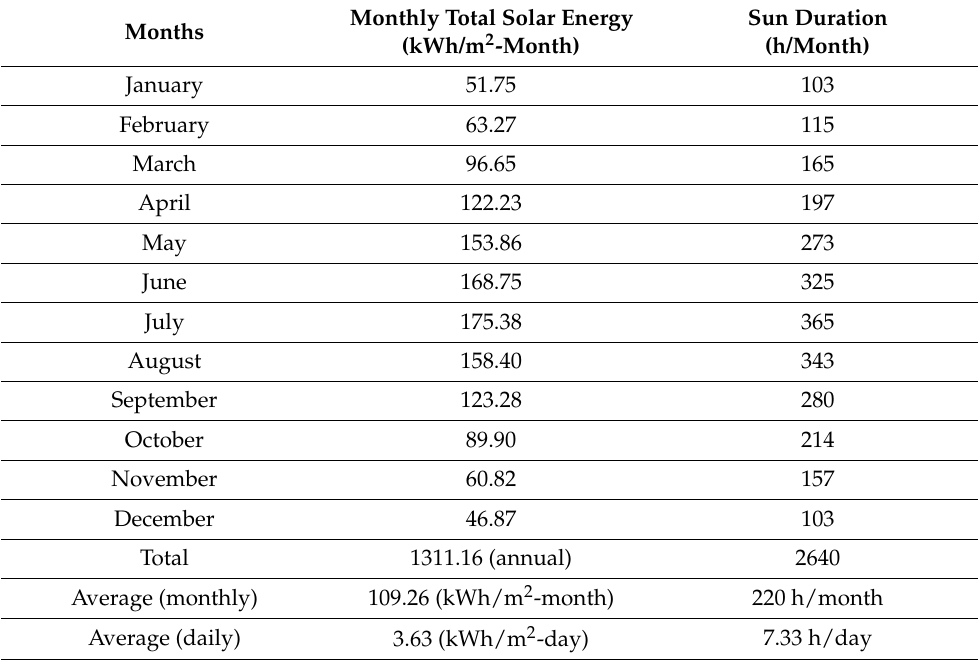
Table 3. Monthly total solar energy and sun duration in